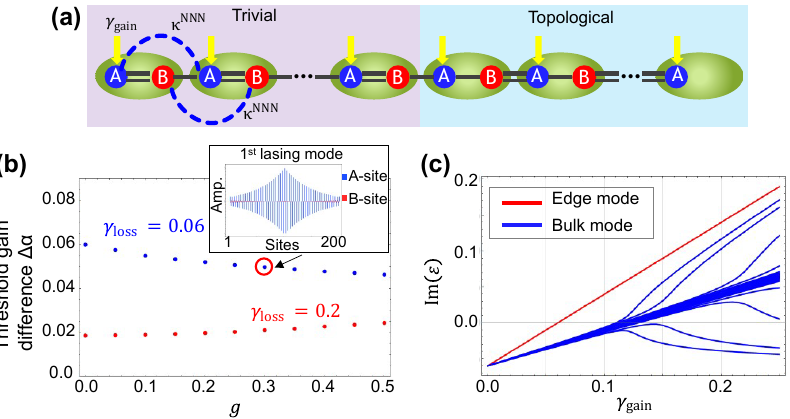
Figure 6: Robustness against next-nearest-neighbor cavity couplings. (a) Extended tight-binding model for the topological laser, including the NNN couplings. NN couplings and NNN couplings are given as 𝜅 NN ,𝜅 NN and 𝜅 NNN , respectively. All sites are subject to loss at a rate of 𝛾 1 2 Threshold gain difference Δ 𝛼 as a function of ratio g of NNN couplings to NN couplings in a finite system consisting of n n topo = 101 topological cavities. Blue and red dots are for the loss 𝛾 loss = 0.06 and 0.2, respectively. The inset in (b) provides a representative sample of the edge mode profile for g = 0 . 3 where blue and red bars indicate the amplitudes on A -site and B -site, respectively. (c) Imaginary parts of eigenenergies versus supplied gain on A -site 𝛾 mode and bulk modes, respectively. The parameters used are 𝜅